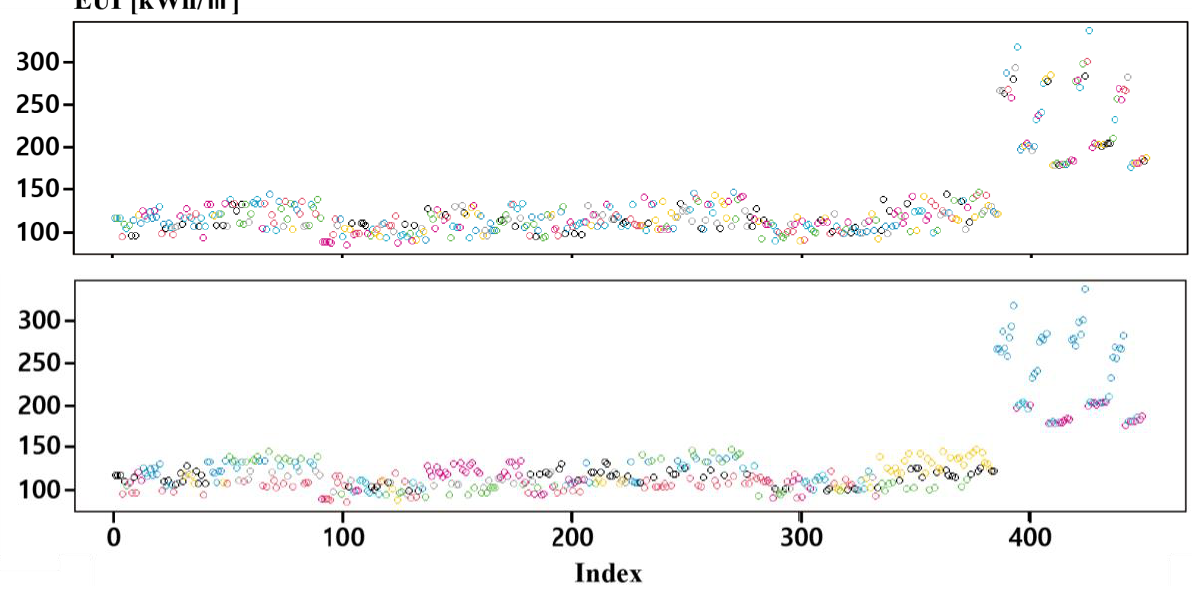
Figure 8. RF clusters ( top ) and CIF clusters ( bottom ).